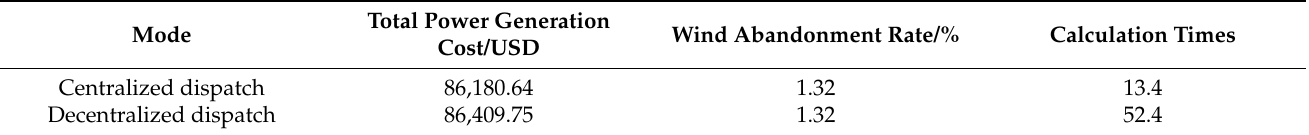
Table 4. Total power generation costs, wind abandonment rates and calculation times of the system in two dispatch modes (two-region 6-node interconnected system).